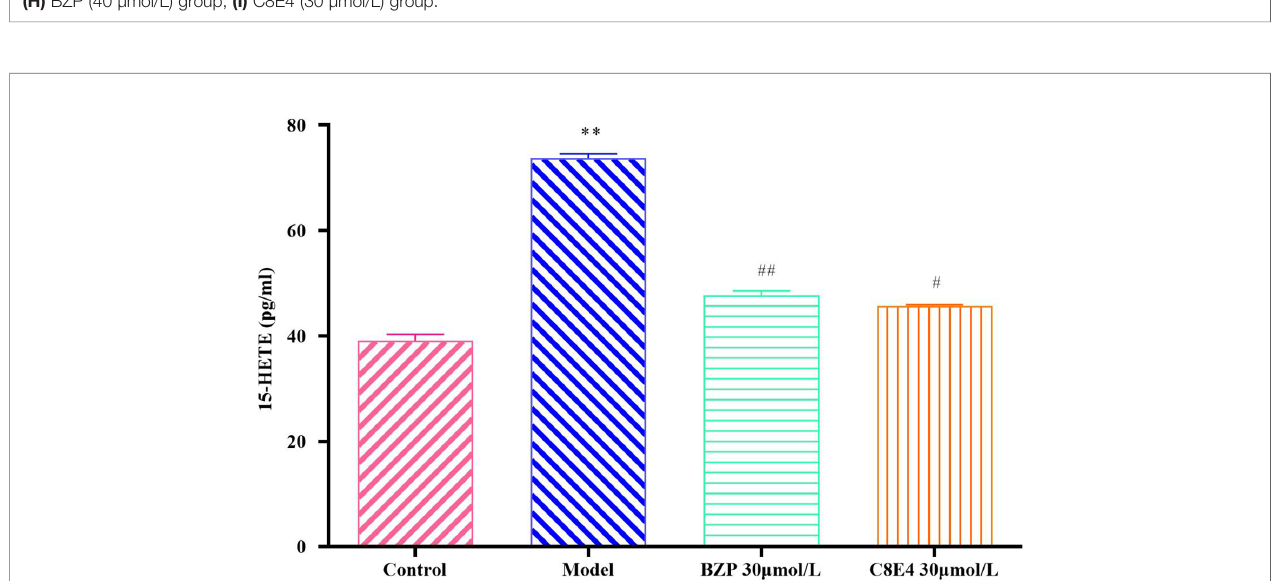
FIGURE 8 | Effect of BZP on 15-HETE levels in PC12 cells induced by OGD/R. PC12 cells were exposed to 30 mmol/L Na 2 S 2 O 4 with low-glucose DMEM for 2 h and then reoxygenation for 24 h, and also pretreated with BZP (30 m mol/L) and C8E4 (30 m mol/L) for 24 h respectively. Data were presented as mean ± sd. One- way ANOVA test was used to determine statistical signi fi cance. ** P < 0.01 vs Sham group; # P < 0.05, ## P < 0.01 vs Model